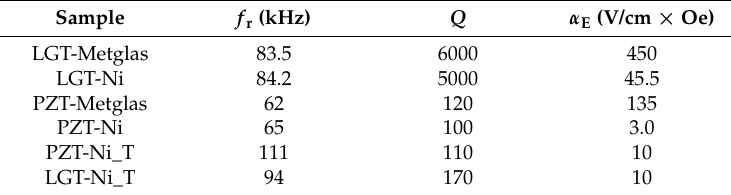
Table 3. Parameters of the resonance ME effect at T = 293 K.